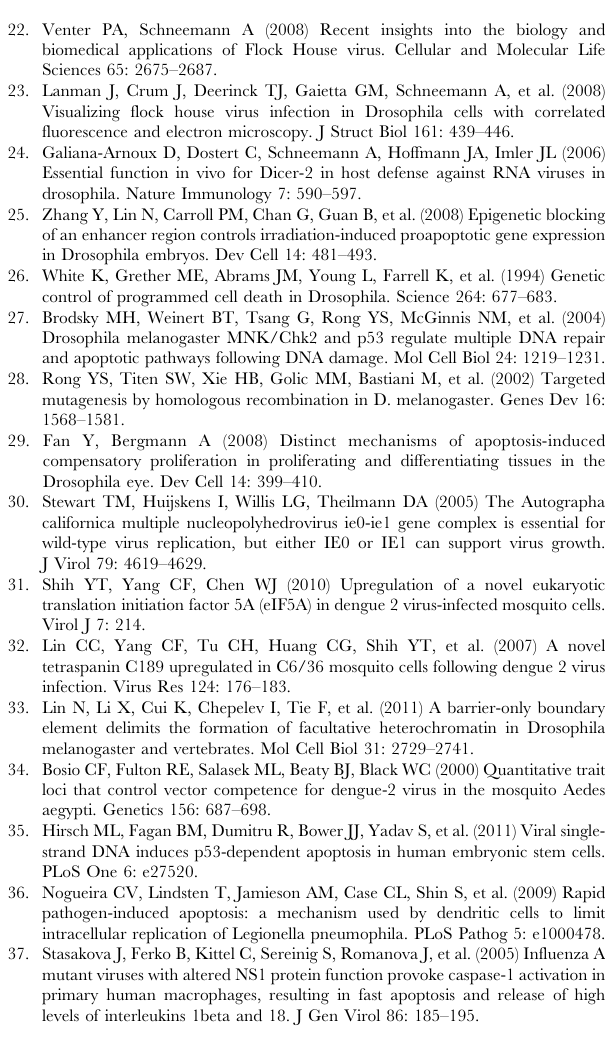
Figure S2 JAK-STAT pathway was not activated follow- ing AcMNPV injection. Q-PCR measurements of hid and vir-1